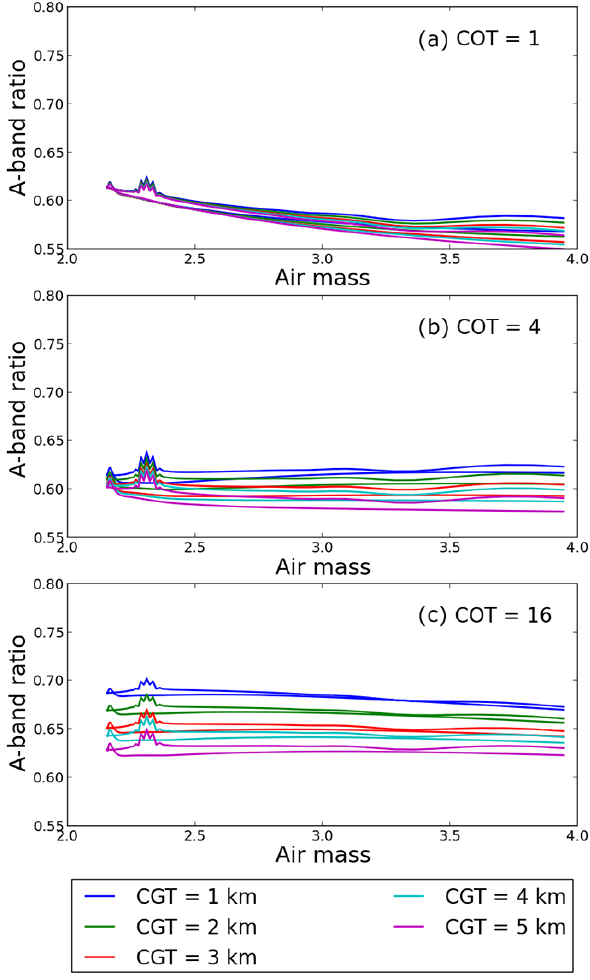
Figure 10. Same as Figs. 5 and 8 with a surface albedo of 0.8. (a) COT = 1, (b) COT = 4, (c) COT =